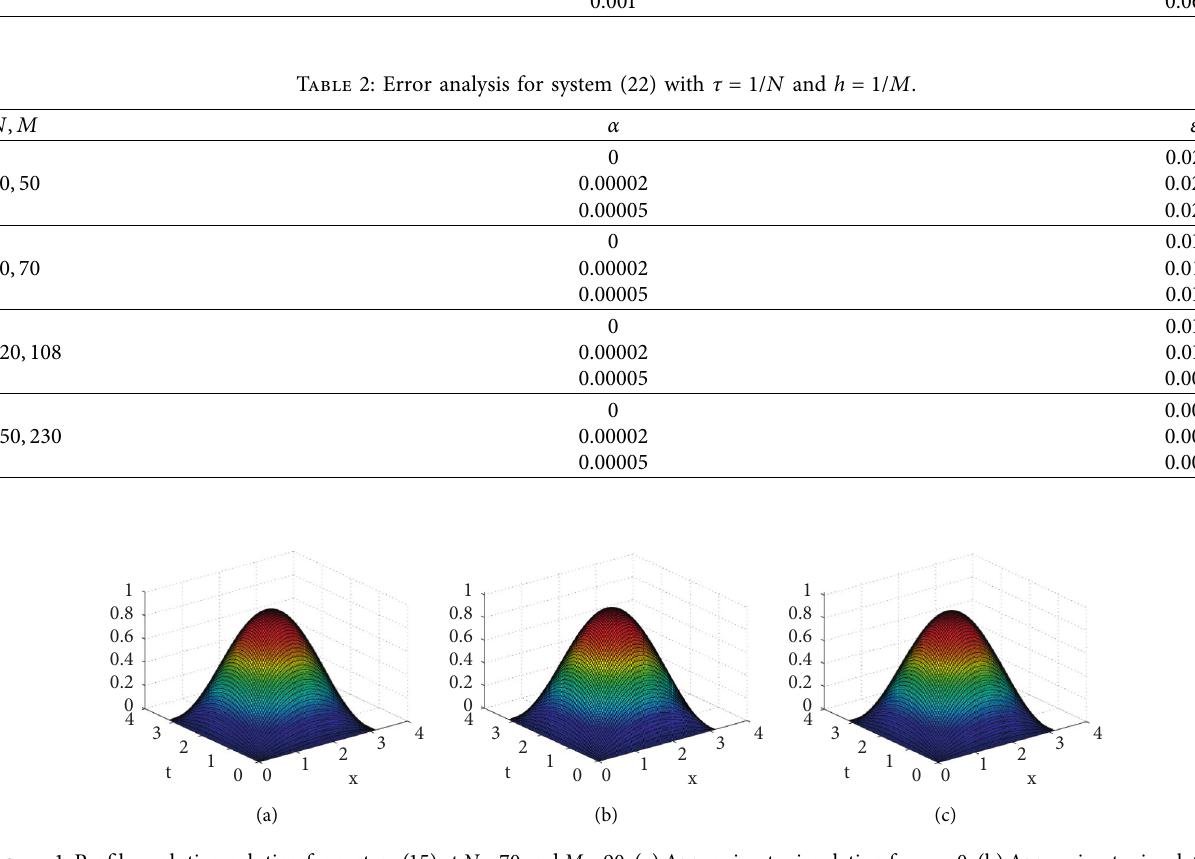
Figure 1: Profile evolution solution for system (15) at N � 70 and M � 90. (a) Approximate simulation for α � 0. (b) Approximate simulation for α � 0 . 001. (c) Analytic